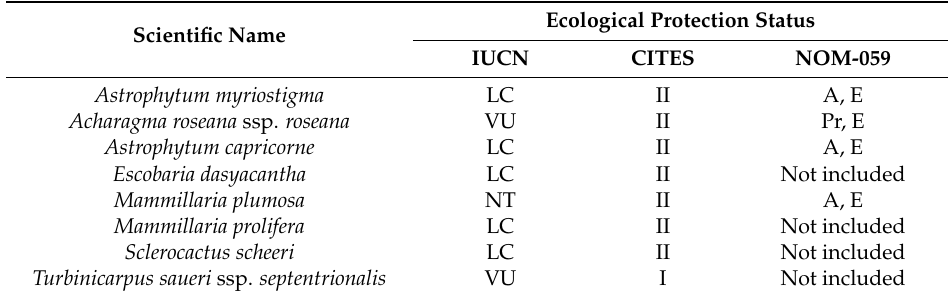
Table 1. Ecological protection status of the 8 species of Cactaceae under study.